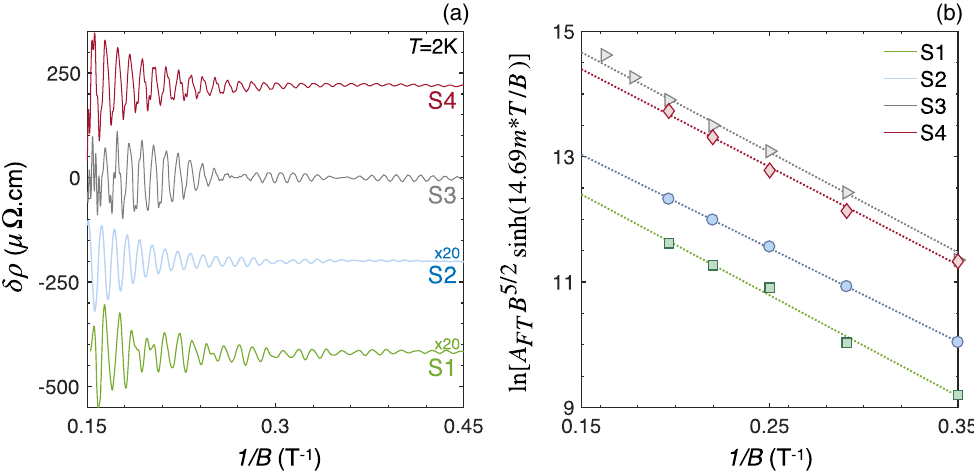
FIG. 5. Invariability of Dingle mobility in contrast to transport mobility. (a) Oscillatory part of the magnetoresistance (for B along the trigonal axis) as a function of 1 =B at T ¼ 2 K in different samples. Curves are shifted vertically and multiplied by a factor 20 for S1 and S2. (b) Dingle analysis of the amplitude A of the 100 T peak of the Fourier transform of δρ in the aforementioned sample. In spite of FT more than one order-of-magnitude difference in residual resistivity, the lines are parallel, indicating no detectable difference in Dingle